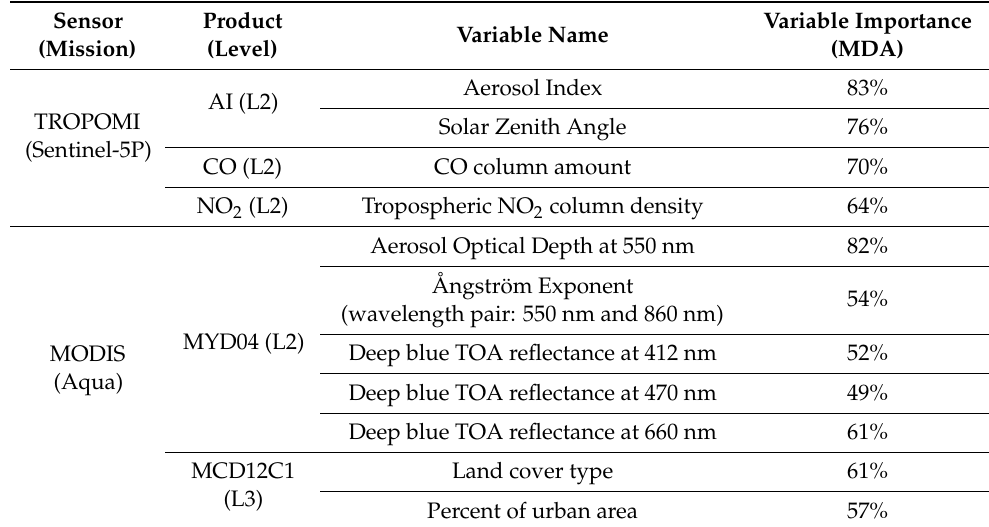
Table 3. List of satellite input variables and variable importance